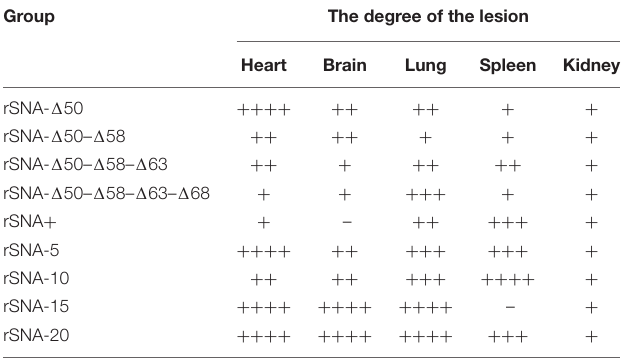
TABLE 2 | Morphometric analysis of histopathological lesion score. Group The degree of the lesion Heart Brain Lung Spleen